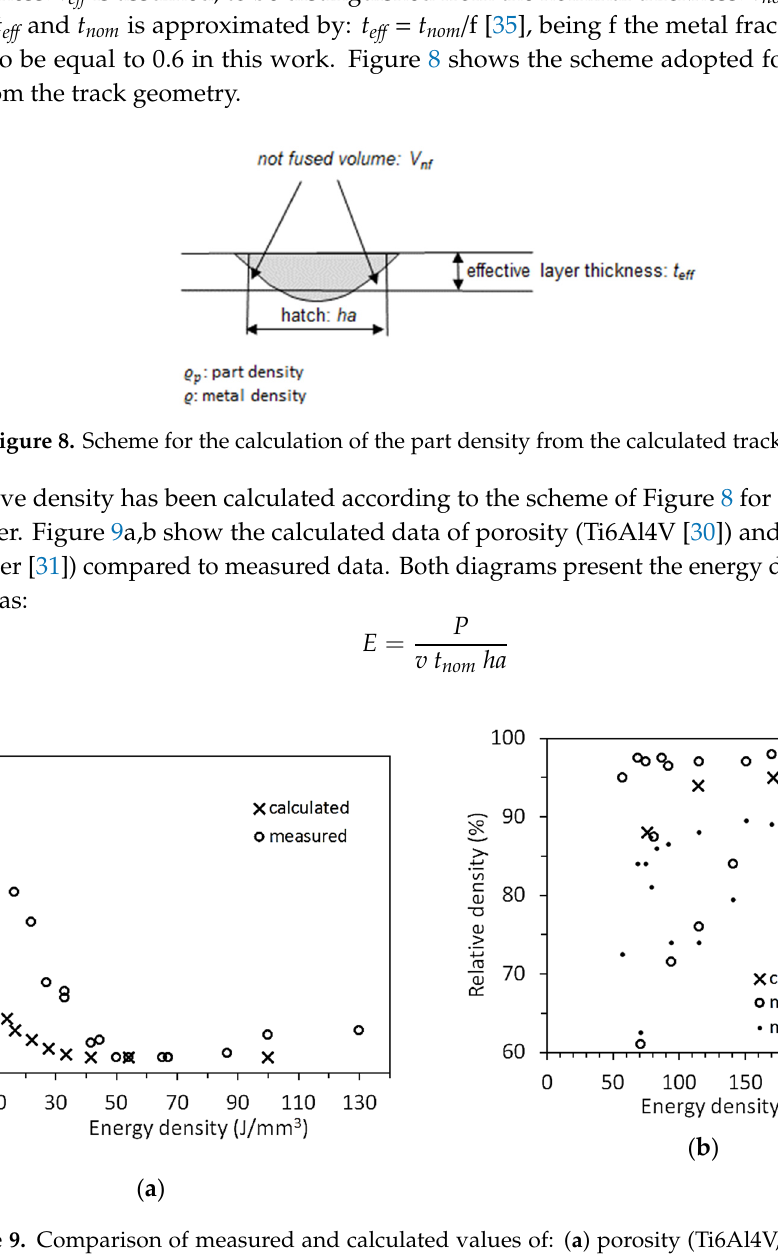
Figure 7. Comparison of measured [21] and calculated values of total absorptivity of alloy 316L.